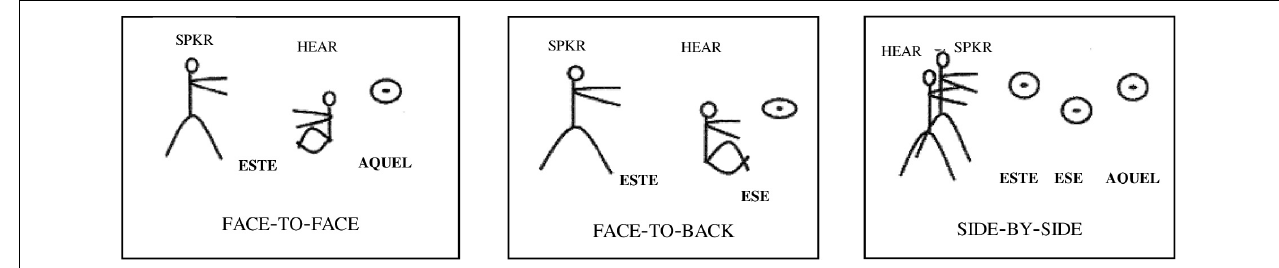
FIGURE 4 | Constellation of speech participants in Jungbluth’s study of Spanish demonstratives (adopted from Jungbluth,